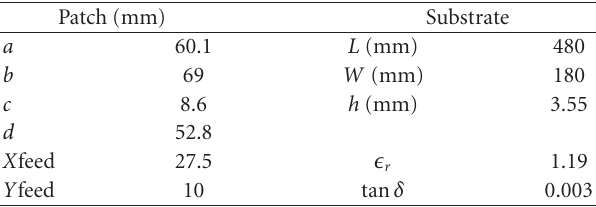
Figure 1: Side view of the textile antenna array and its geometrical dimensions. Table 1: Tip-truncated ETMPA on the Azzurri substrate: dielectric properties and patch